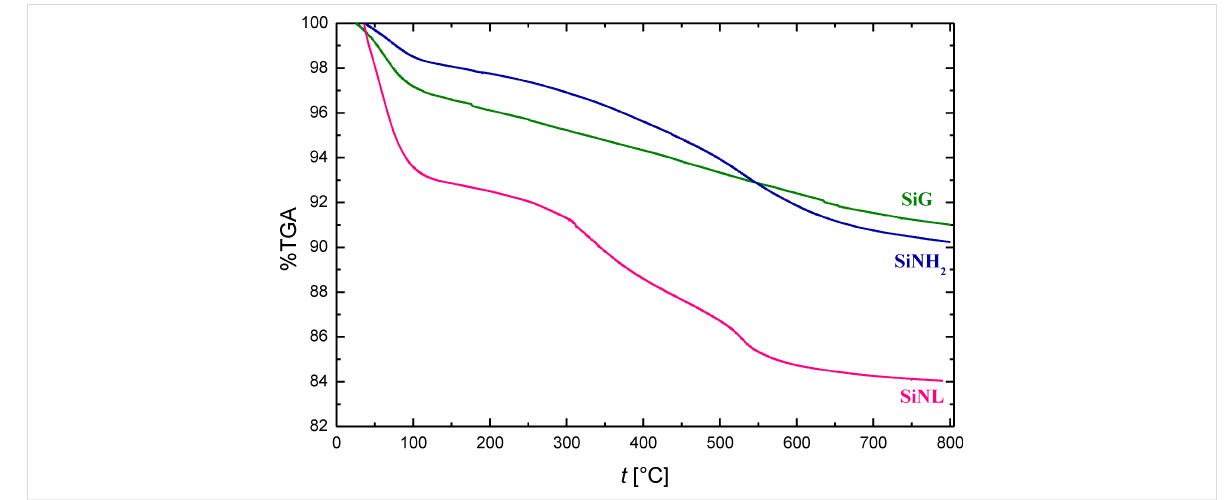
Figure 3: Thermogravimetric profiles of free silica SiG, SiNH 2 and SiNL.